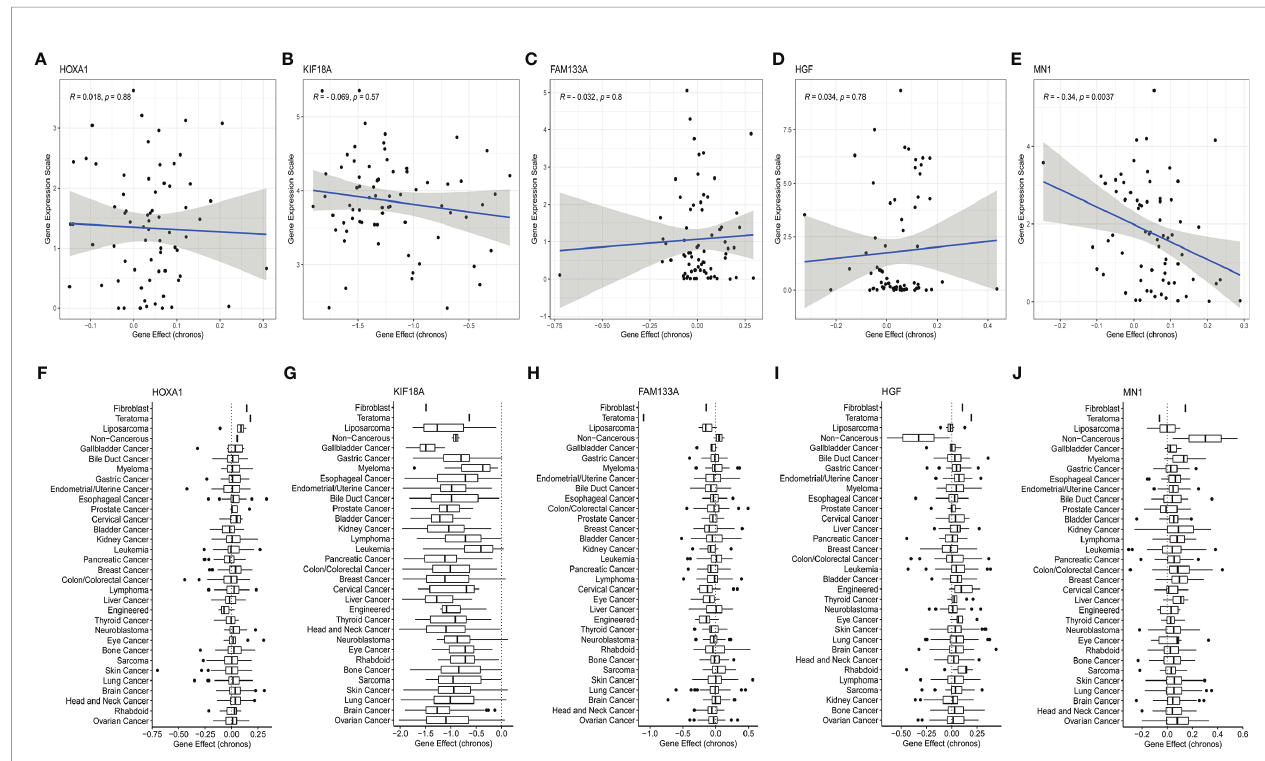
FIGURE 8 | Evaluation of the potential therapeutic targets of risk signature genes based on the CCLE database. (A – E) Scatter distribution of gene expression and gene effect of the 5 genes, including HOXA1, KIF18A, FAM133A, HGF, and MN1, in brain cancer cell lines. (F – J) Distribution of gene effects of the 5 genes, including HOXA1, KIF18A, FAM133A, HGF, and MN1, in various cancer cell